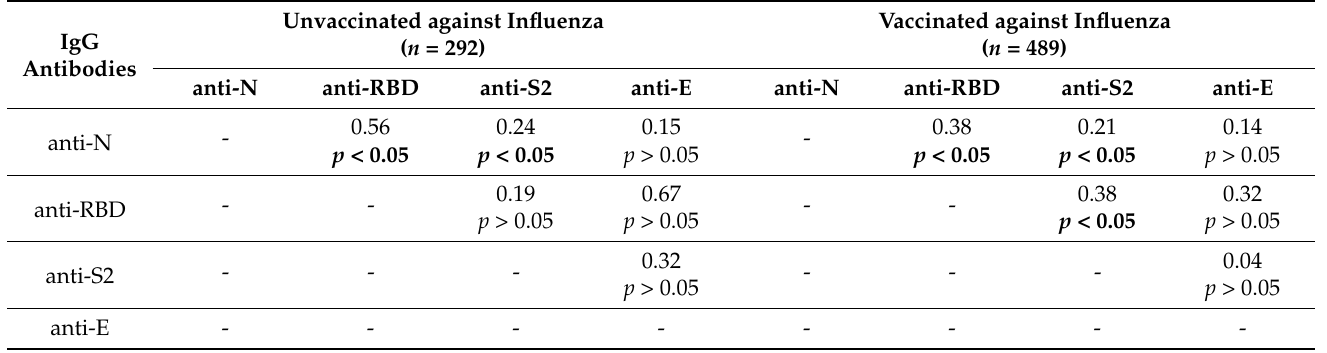
Table 3. Relationship (given as Spearman’s rank correlation coefficient) between serum concentrations of IgG antibodies against SARS-CoV-2 nucleocapsid protein (anti-N), receptor binding domain of spike protein (anti-RBD), subunit S2 of spike protein (anti-S2), and envelope protein (anti-E) in mild COVID-19 convalescent individuals not vaccinated and vaccinated against seasonal